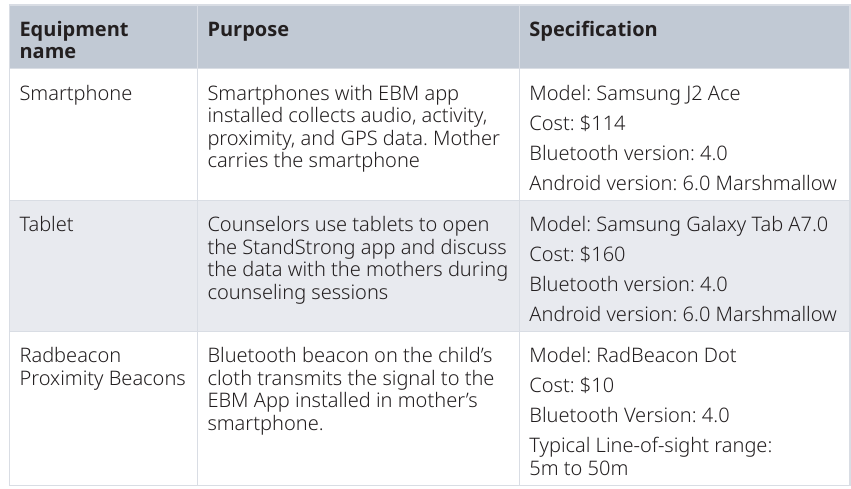
Table 1. Equipment used along with